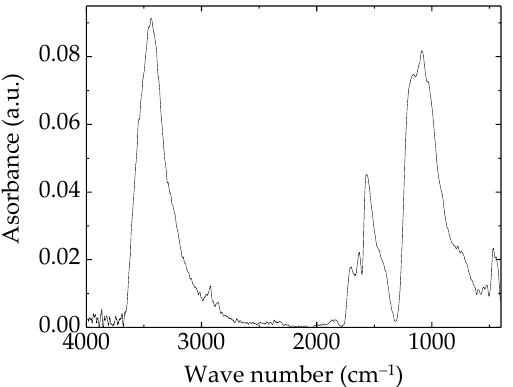
Figure 1. FTIR spectrum of prepared reduced graphene oxide.